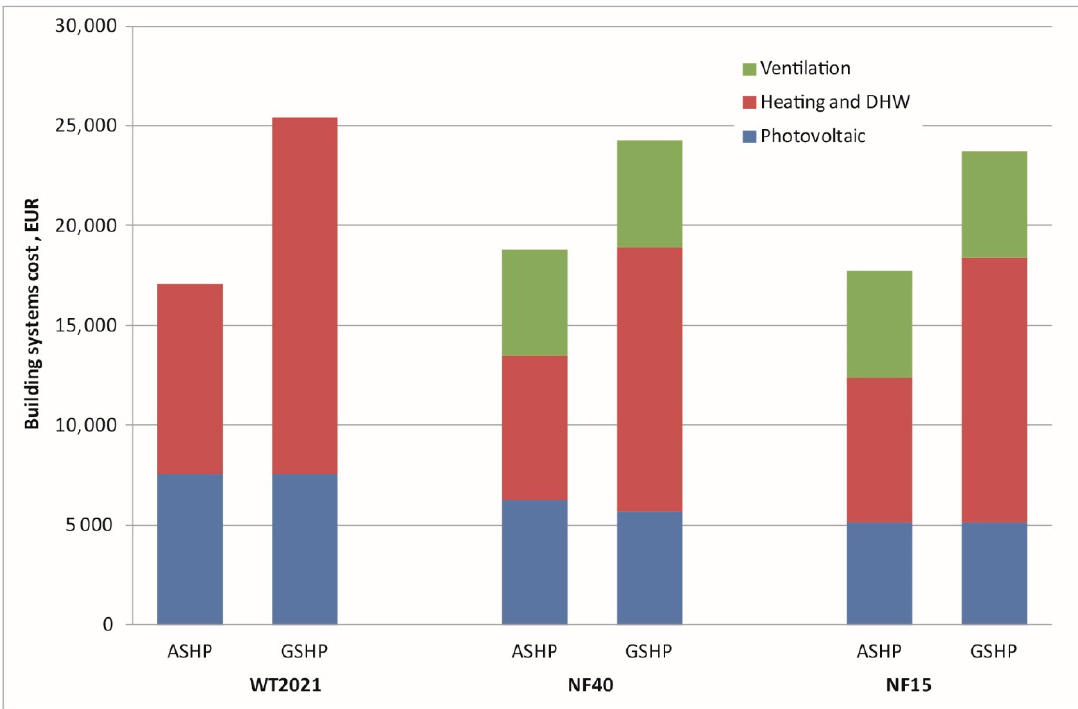
Figure 4. Energies 2019 , 12 , x FOR PEER REVIEW